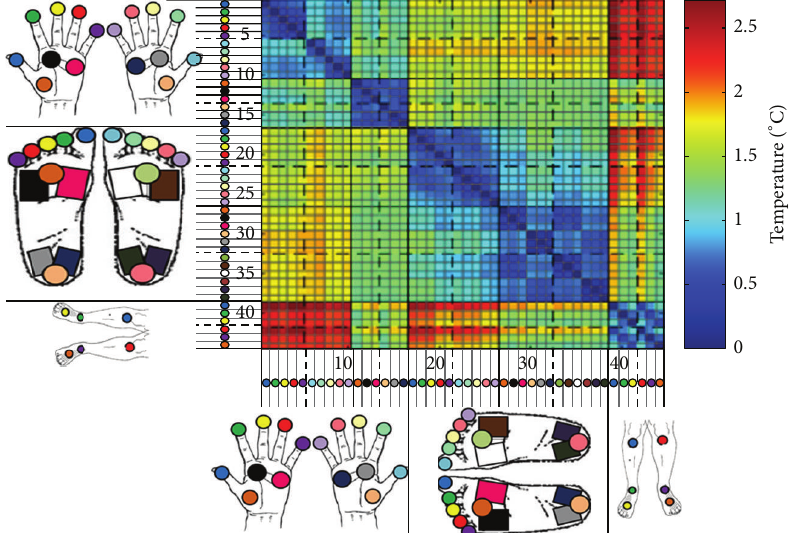
Figure 7: Matrix of the standard deviations of the participant-averaged thermographic temperature mean differences between each region-